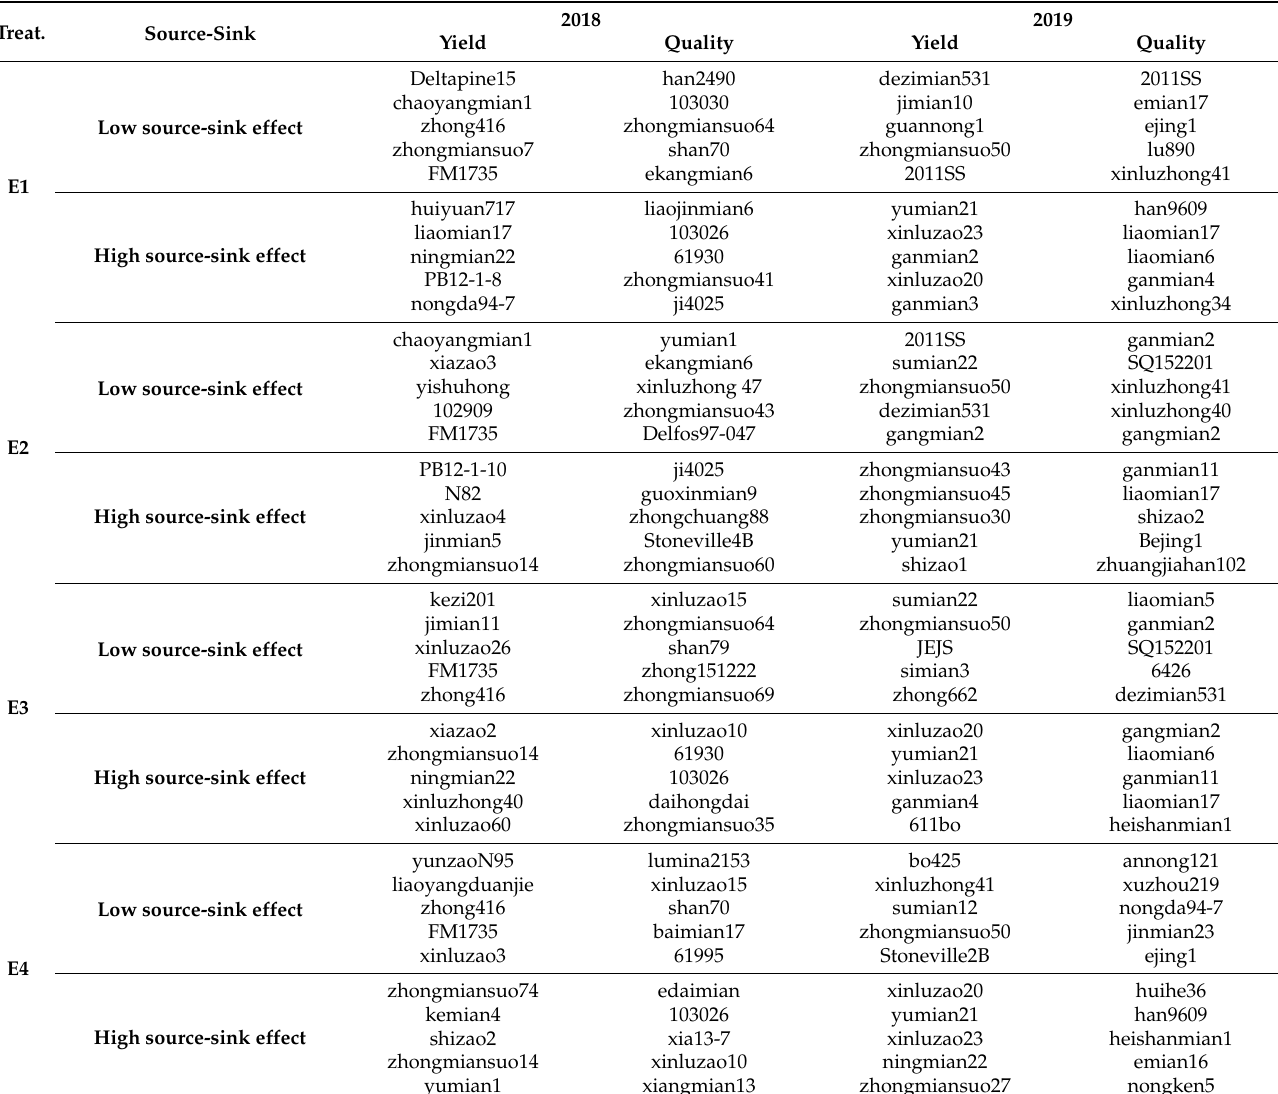
Table 3. Top five selected genotypes for high and low source-sink effects for yield related and fiber quality traits.